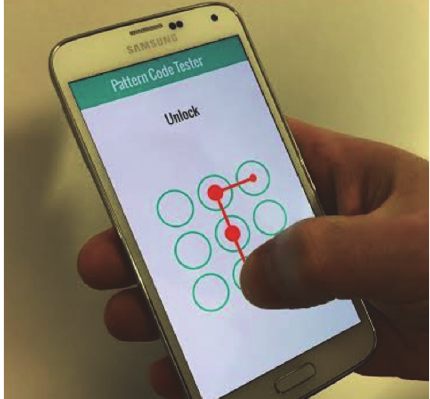
Figure 4: Our Android prototype allows users to experiment with the proposed lock mechanism. The smaller red dot (top right node) has been selected once, whereas the larger red dots (center column) have been selected